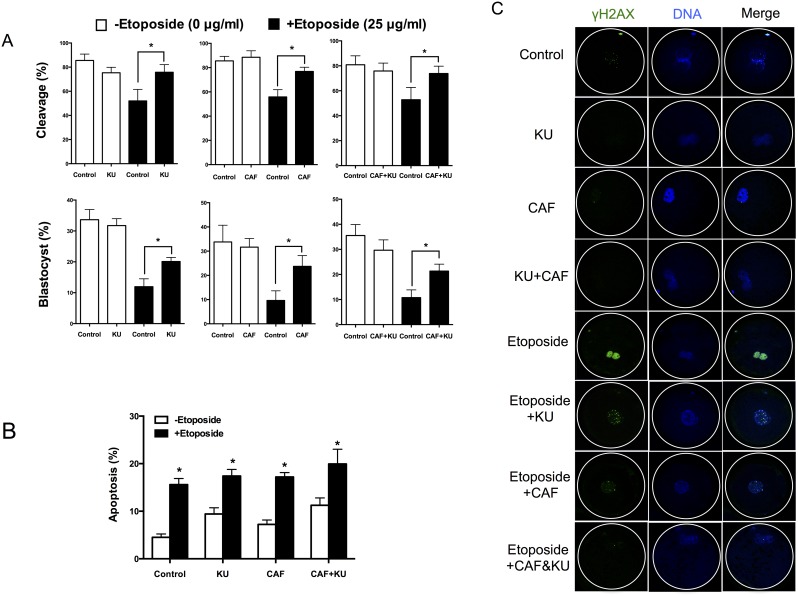
The effect of caffeine and KU55933 on embryonic development after etoposide treatment.Embryos were treated with etoposide (25 μg/mL) with or without caffeine (5 mM) and/or KU55933 (10 μM). (A) Cleavage and blastocyst rates were detected after 28 h and 7 days of culture, respectively. Data are from 3 independent replicates with a minimum of 20 embryos in each group. * P < 0.05. (B) Apoptosis rates were detected at day 7 of culture. Asterisks denote a significant difference from the controls, which were not treated with etoposide (* p < 0.05). (C) The levels of γH2AX in the nuclei of 1-cell embryos.